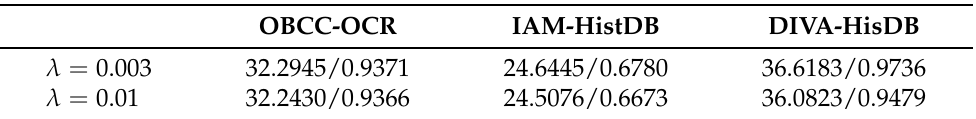
Figure 7. Differences in PSNR and SSIM with and without semantic loss, depending on SR image resolution. Table 3. Effect of λ in Equation (2) on the performance of the proposed method. The values to the left and right of ‘/’ represent the PSNR and SSIM,